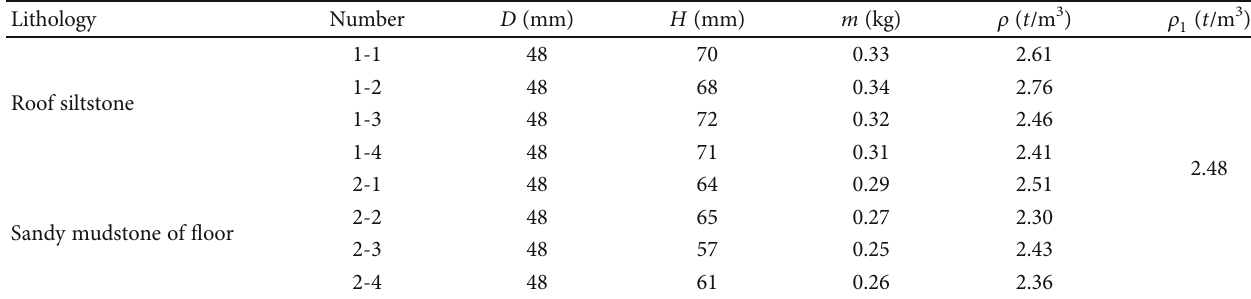
Table 3: Determination of rock mass density.